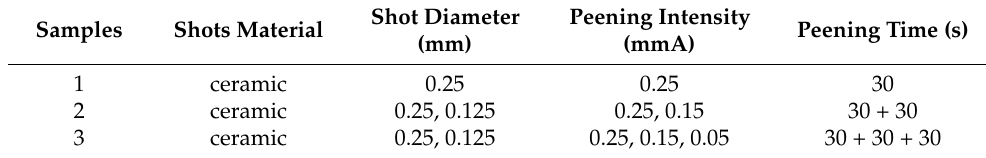
Table 1. Parameters of multiple shot